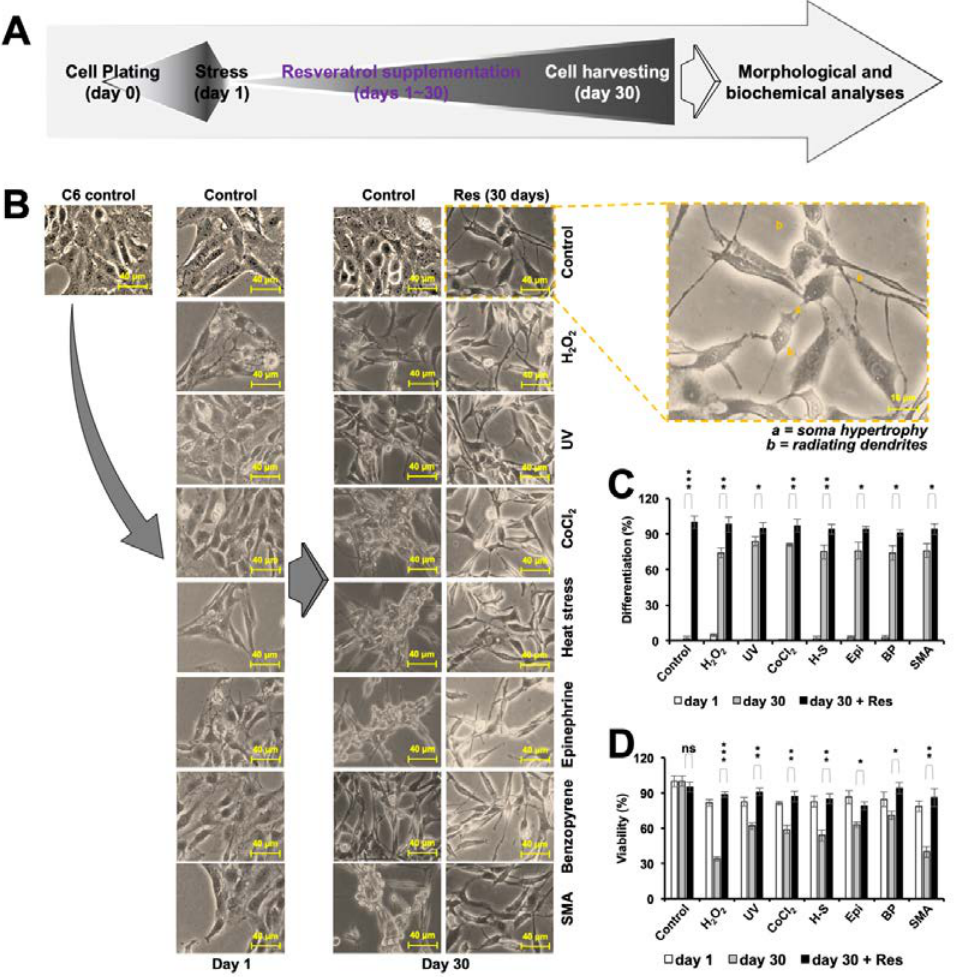
Figure 4. Cell di ff erentiation in glioma upon chronic resveratrol treatment. Flowchart ( A ) and images ( B ) summarizing morphological features of C6 cells, before and after induction of stress, throughout 30 days treatment with resveratrol (Res) with / without the prior stressed state. ( C ). Histogram showing the extent of di ff erentiation (percent di ff erentiation) as evaluated from three independent experiments. The number of cells showing di ff erentiated morphology out of 100 cells from three random fields was plotted on a histogram, where control was taken as 100%. ( D ). Histogram showing loss of viability of C6 cells in response to stress followed by recovery with resveratrol treatment.